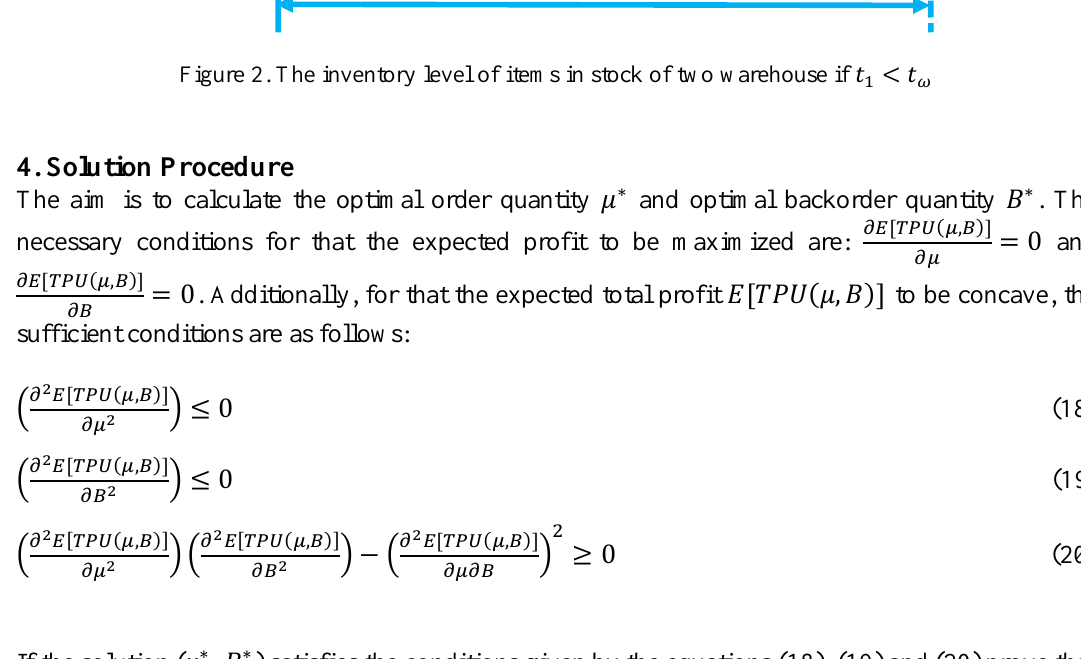
Figure 2. The inventory level of items in stock of two warehouse if 𝑡